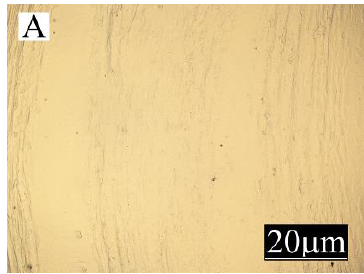
Figure 11. The appearance of individual parts of the injection moulding obtained with a 15% content of the bran fraction with a grain size of 0.6 – 0.8 mm at measuring points A, M, B (the positions of the points are marked in Figure 1).